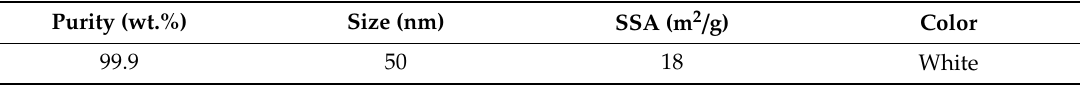
Table 2. Characteristics of the high-grade of α -Al 2 O 3 nanoparticles (SSA, specific surface area). Purity